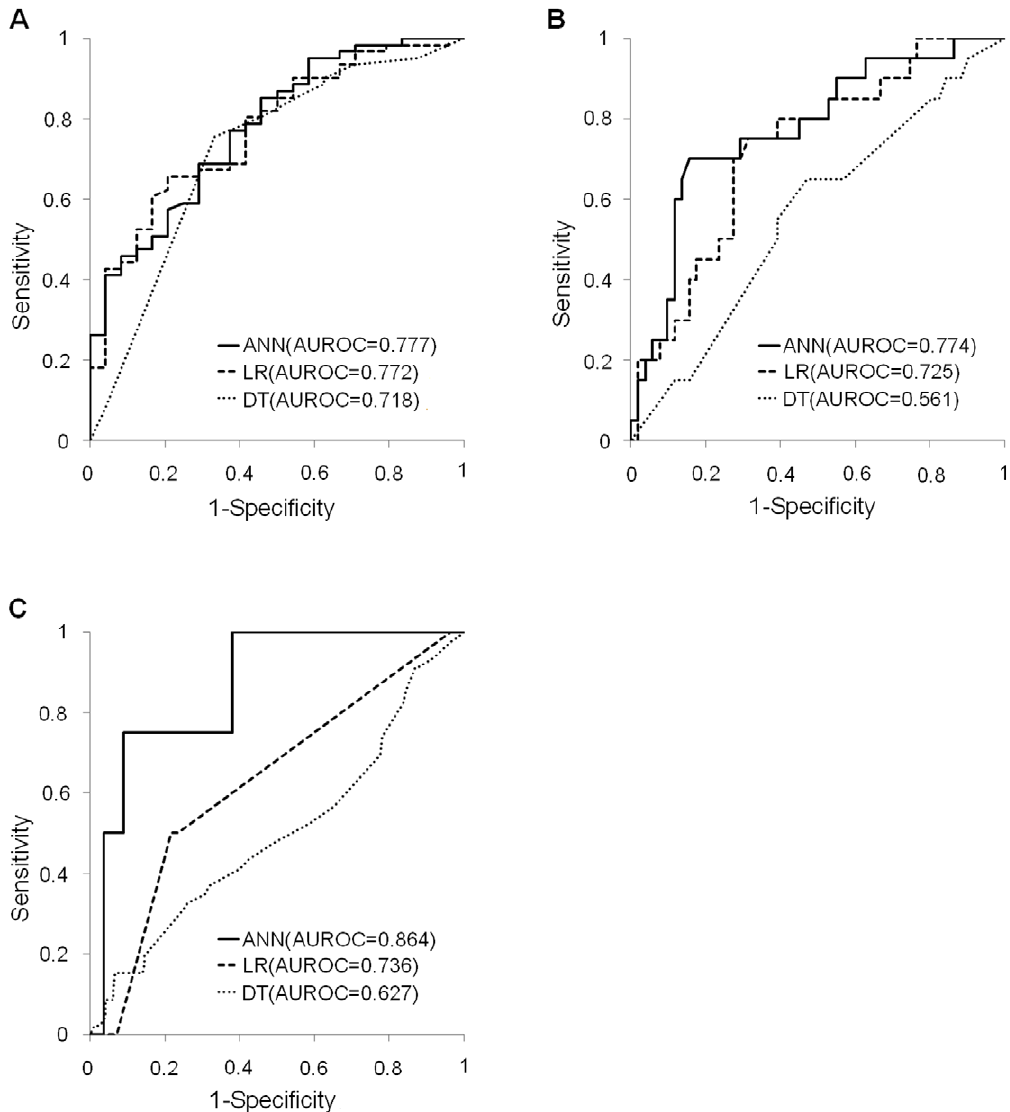
Figure 3. ROC curves and AUROCs for the 1-, 3- and 5-year disease-free survival models constructed for validation groups using ANN, LR and DT. The AUROC values for 1-year (A), 3-year (B) and 5-year (C) disease-free survival were 0.777, 0.774 and 0.864 for ANN models, 0.772, 0.725 and 0.736 for LR models, and 0.718, 0.561 and 0.627 for DT models, respectively. In all disease-free survival models for validation groups, AUROC values obtained by ANN were superior to those obtained by LR and DT.